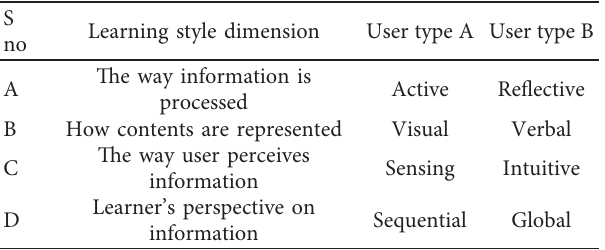
Figure 1: Overall approach for research. Table 4: Learning style